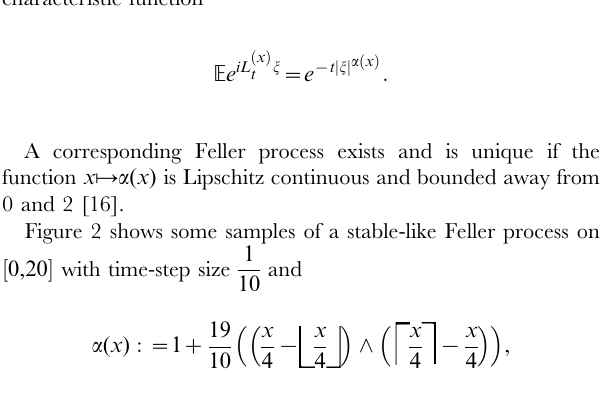
q(cid:3) (cid:4)(cid:3) (cid:4) q ffiffiffiffiffiffiffiffiffiffiffiffiffiffiffiffiffiffiffiffiffiffiffiffiffiffi a 2 { ( b z i j ) 2